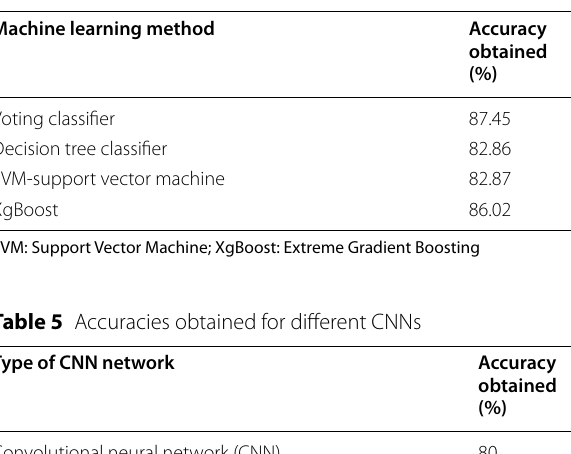
Table 4 Accuracies obtained for different models of machine learning